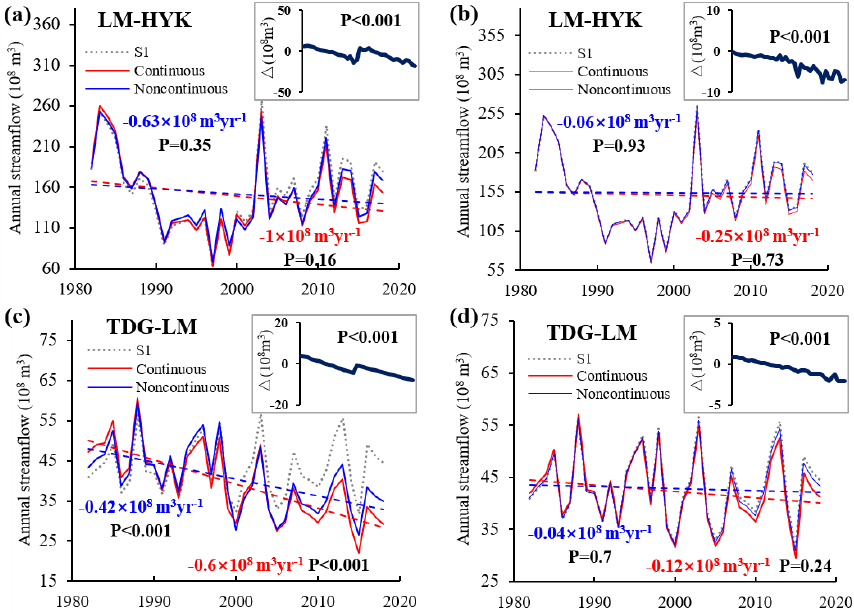
Figure 12. The comparison of the simulated annual streamflow trend using VIC considering and without considering continuous dynamics of interannual LAI (a, c) and intra-annual temporal pattern of LAI (b, d) in the TDG–LM and LM–HYK subregions. The insets show the time series of the difference between simulated annual streamflow with VIC considering and without considering continuous LAI dynamics, and its significance level of change